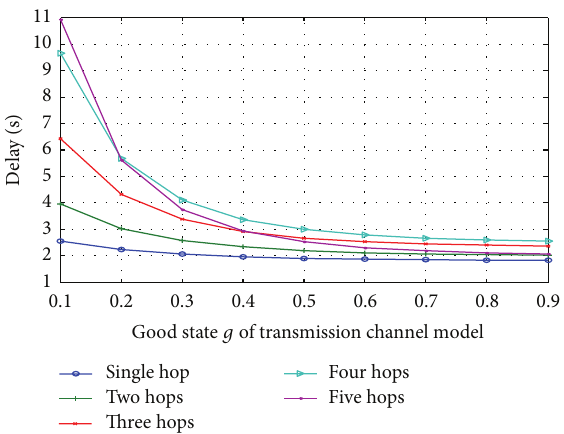
Figure 15: The minimization end-to-end delay under integer opti- mization programming.